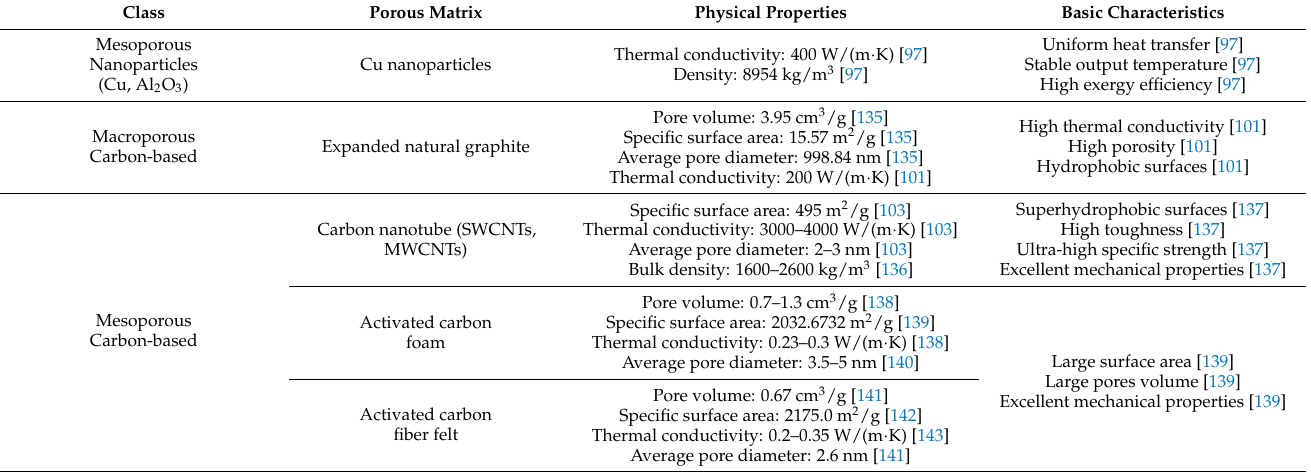
Table 5. Basic characteristics of common porous